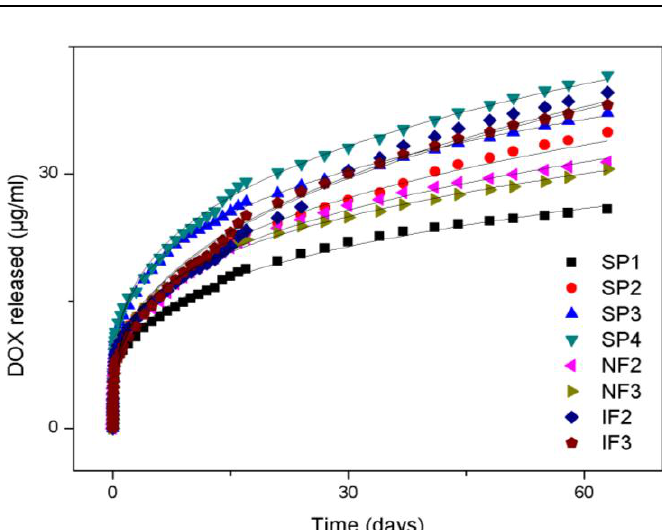
Figure 10. Long-term release experimental data (symbols) and fitting using the Korsmeyer–Peppas equation (lines). Table 2. Korsmeyer–Peppas equation fitting parameters.